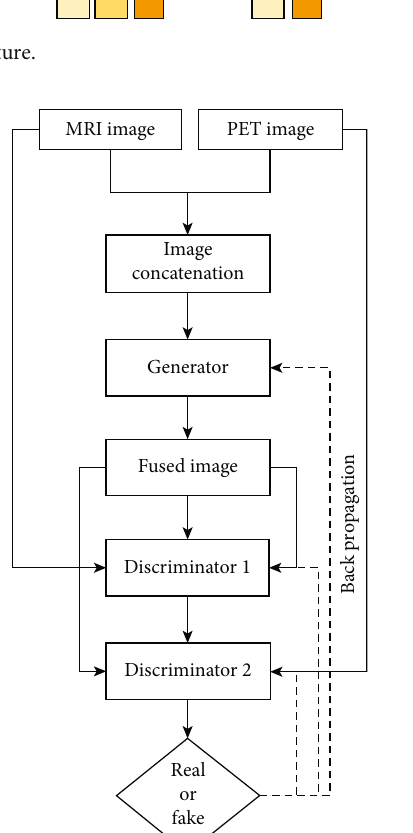
Figure 5: Discriminator architecture.